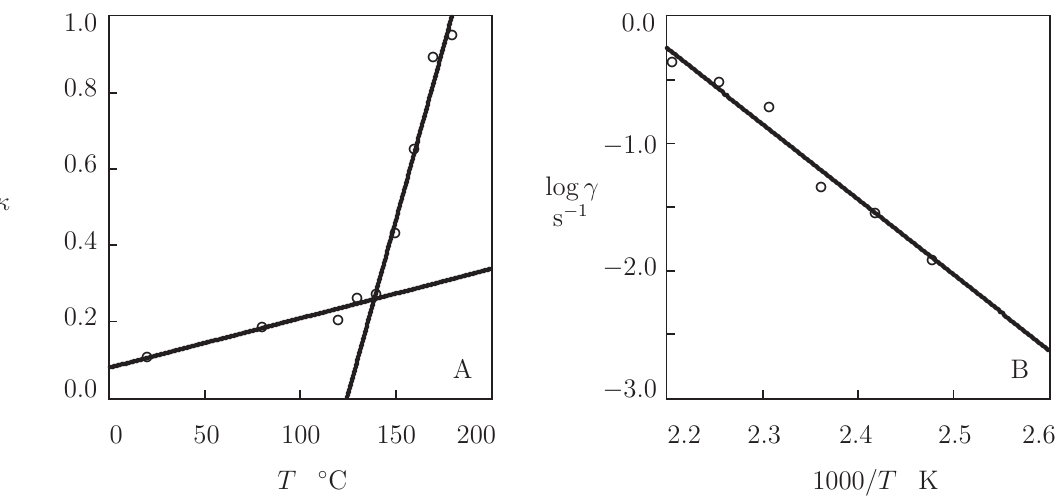
Figure 9. Parameters κ and γ versus temperature T . Circles: treatment of observations in relaxation tests. Solid lines: ( A )—approximation of the data by Equation (14). ( B )—approximation of the data by Equation (15) with E a = 113.4 kJ/mol.